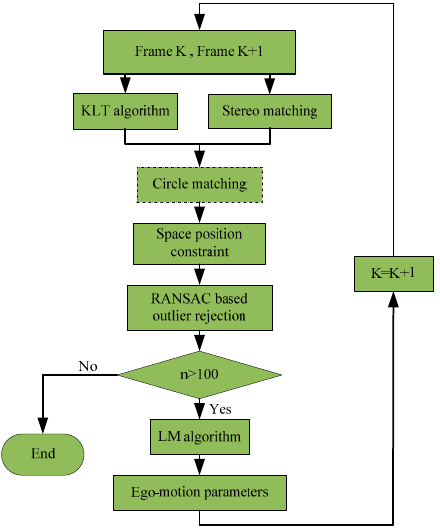
Figure 1. The flowchart of the approach in a tracking cycle.